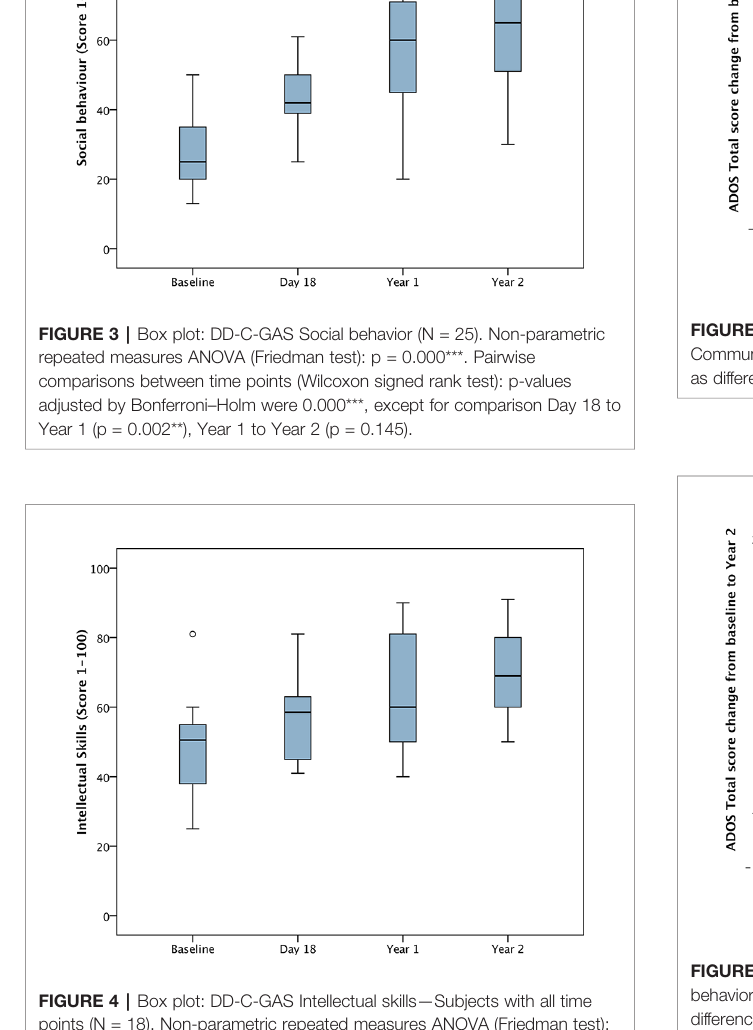
FIGURE 4 | Box plot: DD-C-GAS Intellectual skills — Subjects with all time points (N = 18). Non-parametric repeated measures ANOVA (Friedman test): p = 0.000***. Pairwise comparisons between time points (Wilcoxon signed rank test): p-values adjusted by Bonferroni – Holm were 0.000***for comparison Baseline (Bsl) to Year 2, <0.01** for comparisons Bsl to Day 18 and Year 1, and Day 18 to Year 2, <0.05* for Day 18 to Year 1 and Year 1 to Year 2.